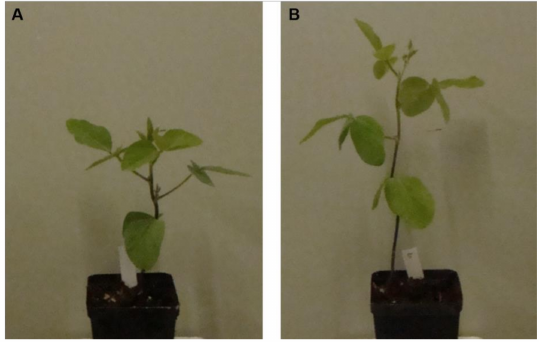
Figure 2. Soybean grown under B310 ( A ) and B60 ( B ). Table 3. Least square means of the final measurement for lengths of internodes, petioles and leaves and diameter of internodes at phytomer scale under di ff erent blue photosynthetic flux densities (BPFD). Lower case letters indicate significant di ff erences between treatments ( p < 0.05).